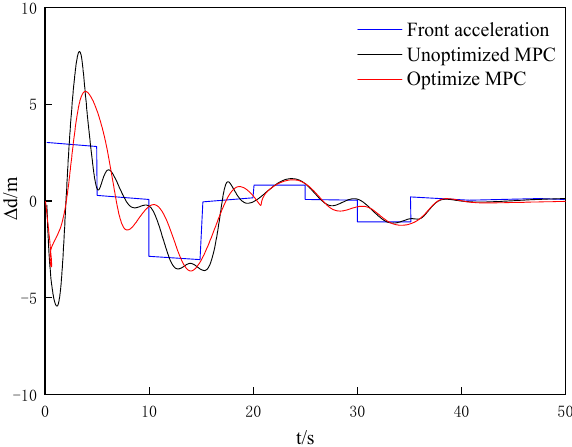
Figure 2. Simulation results of vehicle spacing.